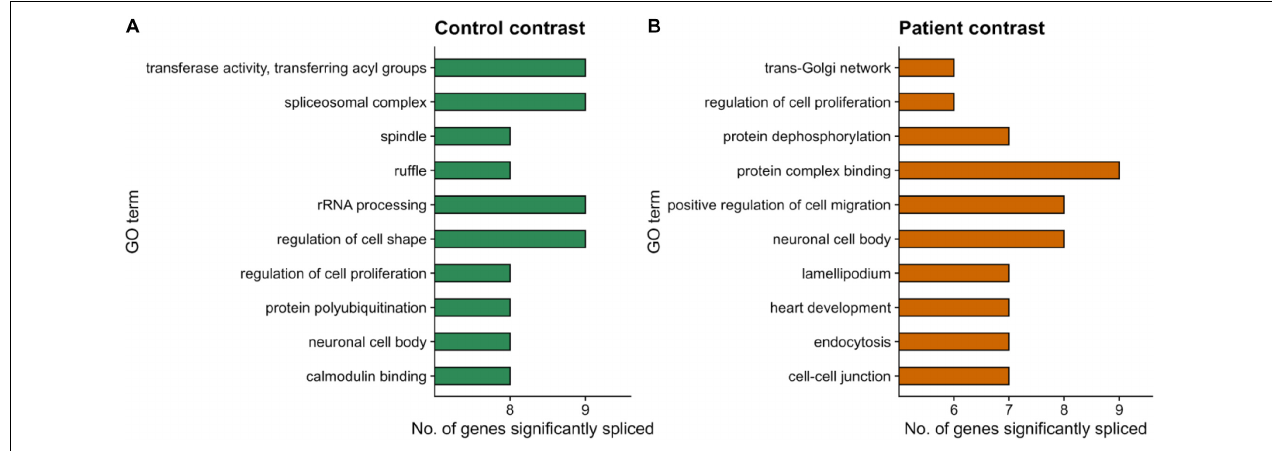
FIGURE 7 | Functional enrichment results for differentially spliced genes ( p value < 0.05) in the within-condition contrasts. (A) Control-fibroblasts vs. Control-RPE. (B) Patient-fibroblasts vs. Patient-RPE. Only events unique to each contrast are considered. The top-10 most frequently annotated GO terms are shown in the y -axis. The number of genes belonging to each GO term is indicated by bar height ( x